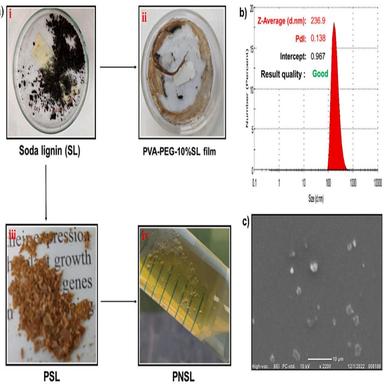
a) Fractionation of SL and preparation of PNSL; (i and ii) Preparation of film using SL (using 10% SL film was brittle); (i and iii) Fractionation of SL to PSL; (iii and iv) Preparation of PNSL from PSL; Characterization of PNSL; b) Zeta size (~ 237 nm); c) SEM image (scale bar 10 μm).